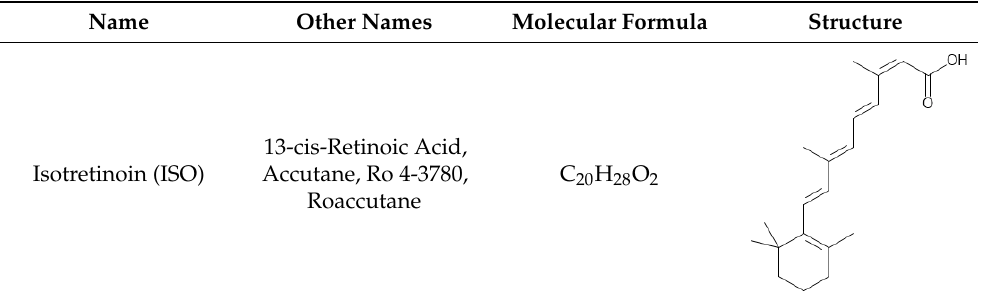
Table 1. Isotretinoin—summary and structural formula [1].